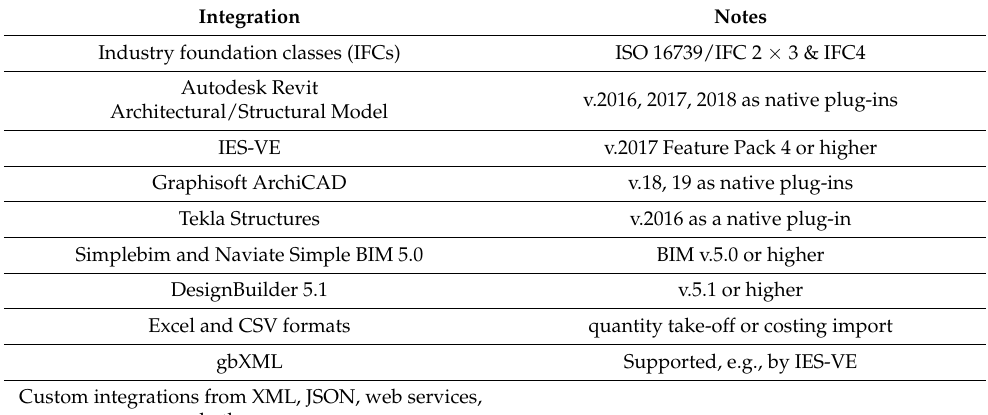
Table 1. Integration options based on software and formats provided by One Click